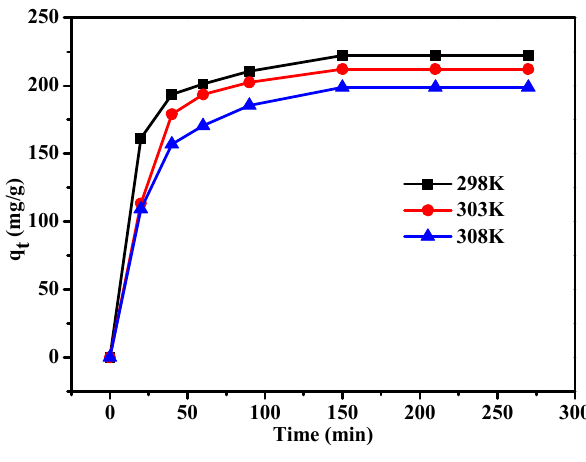
Figure 10. Adsorption kinetics of MSA-AC2. Table 2. Kinetic parameters for the adsorption of MB on